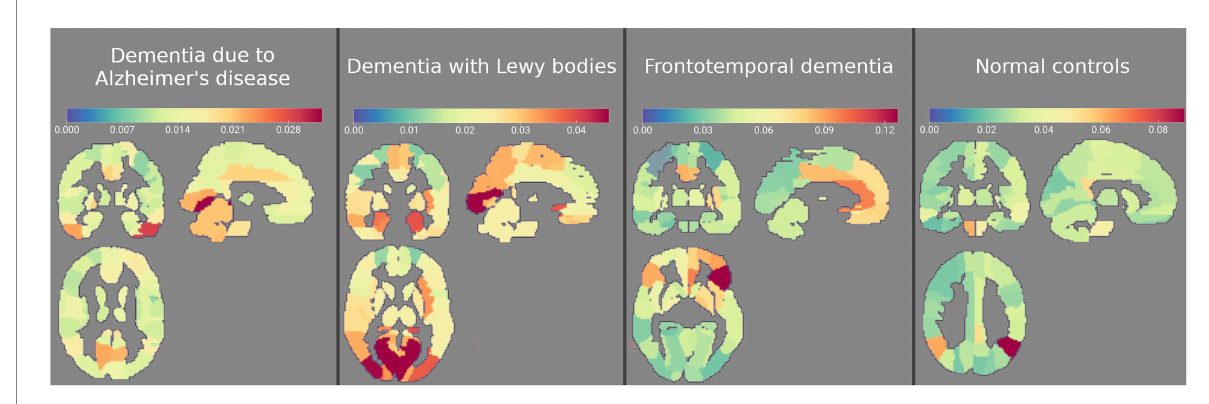
FIGURE 8 Absolute average Shapley values for four groups plotted on an AAL template. The most important features for dementia due to Alzheimer’s disease (AD) classification included bilateral temporal cortices, cerebellum, bilateral lingual, and calcarine sulci, for dementia with Lewy bodies (DLB) occipital cortices, hippocampi and parahippocampi, amygdala, and middle temporal lobes, for frontotemporal dementia (FTD) bilateral frontal cortical regions, middle cingulum and anterior cingulum, and for normal controls (NC) bilateral angular gyri, pons, and vermis. Regions (features) are color-coded blue to red from least to most